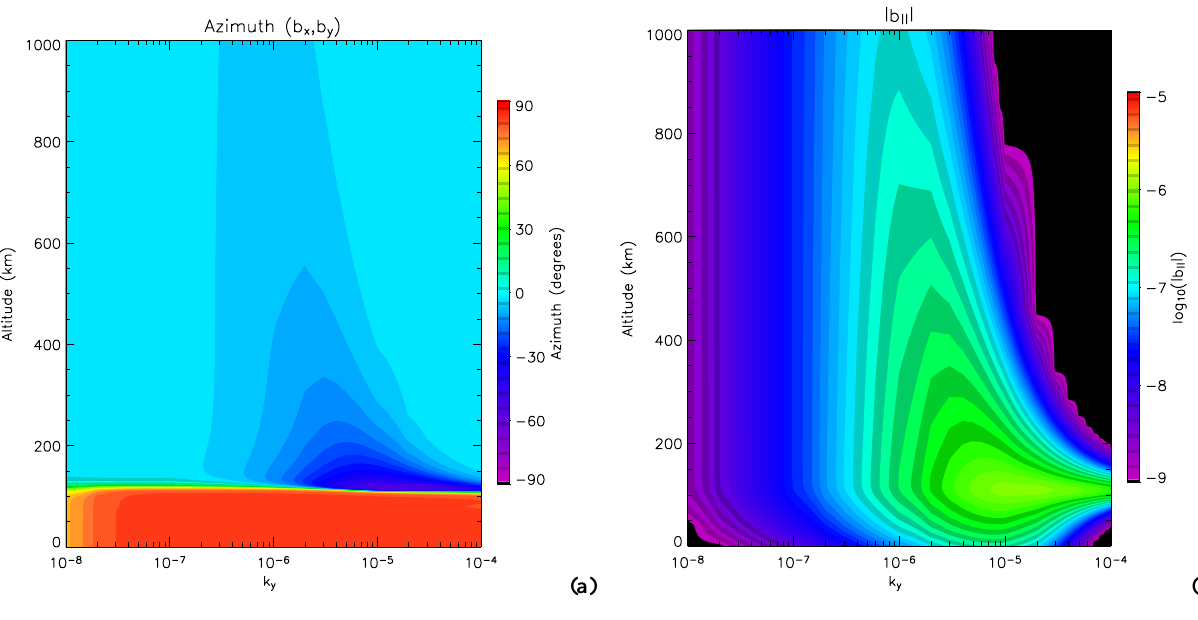
Fig. 4. (a) The polarisation azimuth computed from b x and b y , for a frequency of 16mHz and dip angle of I = 90 ◦ at solar maximum. The wavenumbers are k x = 10 − 10 m − 1 and k y varying between 10 − 8 and 10 − 4 m − 1 . (b) The amplitude of the field aligned (compressional) component of the ULF wave magnetic field ( b z in the case of a vertical field) for the parameters used in